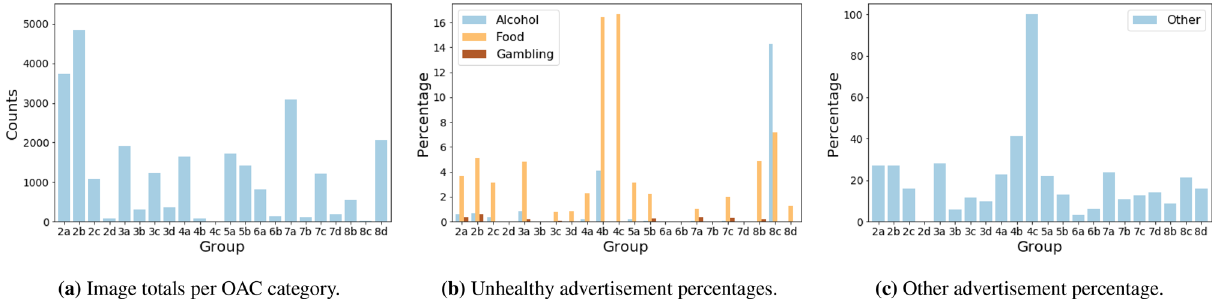
Figure 5. ( a ) Illustrates the number of street-level images per OAC category. ( b , c ) contain the percentage of images per OAC that contain either unhealthy advertisements and those of type ‘other’ respectively.